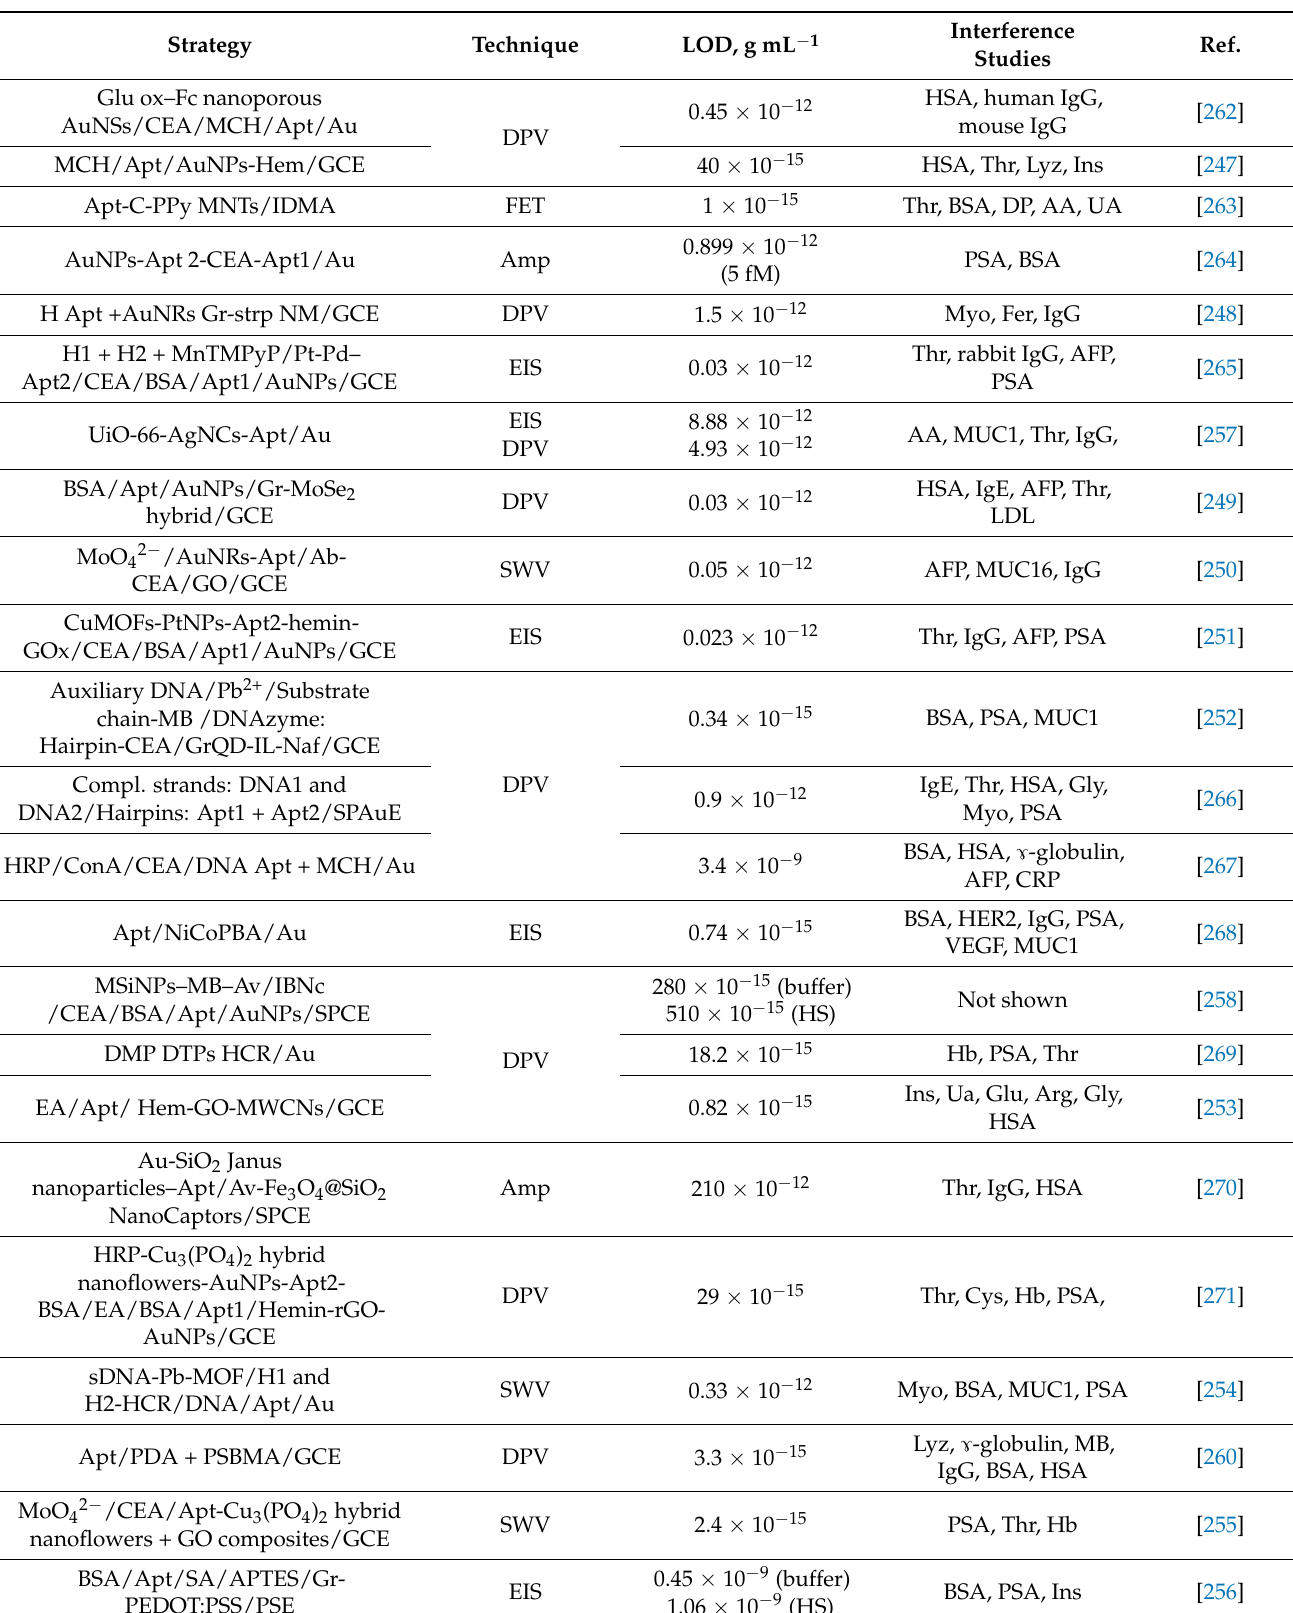
Table 6. The analytical performance of selected electrochemical for CEA. Strategy Technique LOD, g mL − 1